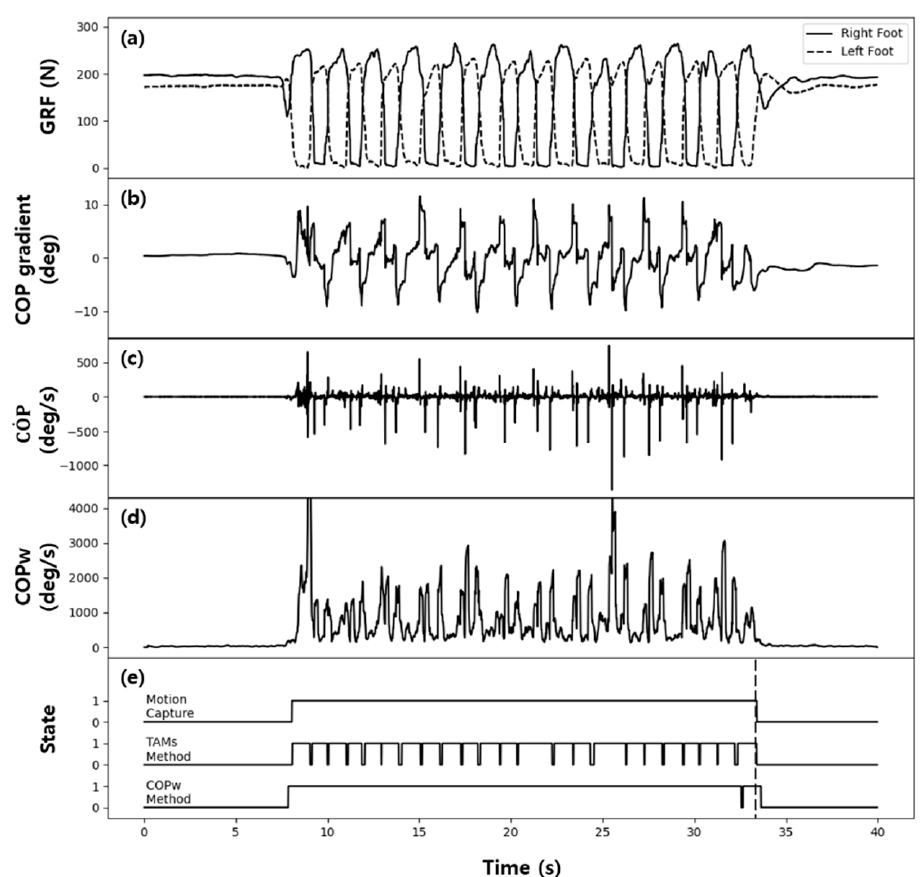
. COP , ( d ) COP W , ( e ) classifica-